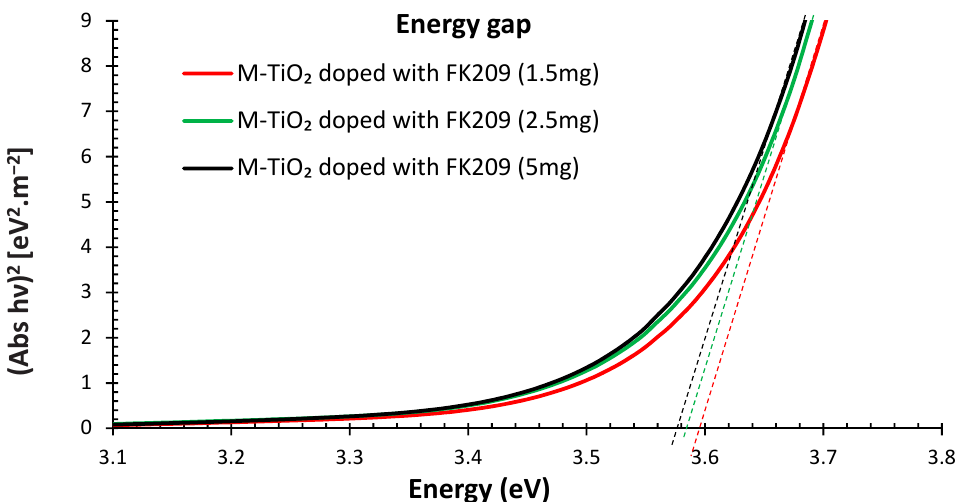
Figure 15. Energy gap of M-TiO 2 doped with various concentrations of FK209 (1.5 mg, 2.5 mg and 5 mg) using Tauc plot. Dotted lines represent the tangent to the slope for each plot.